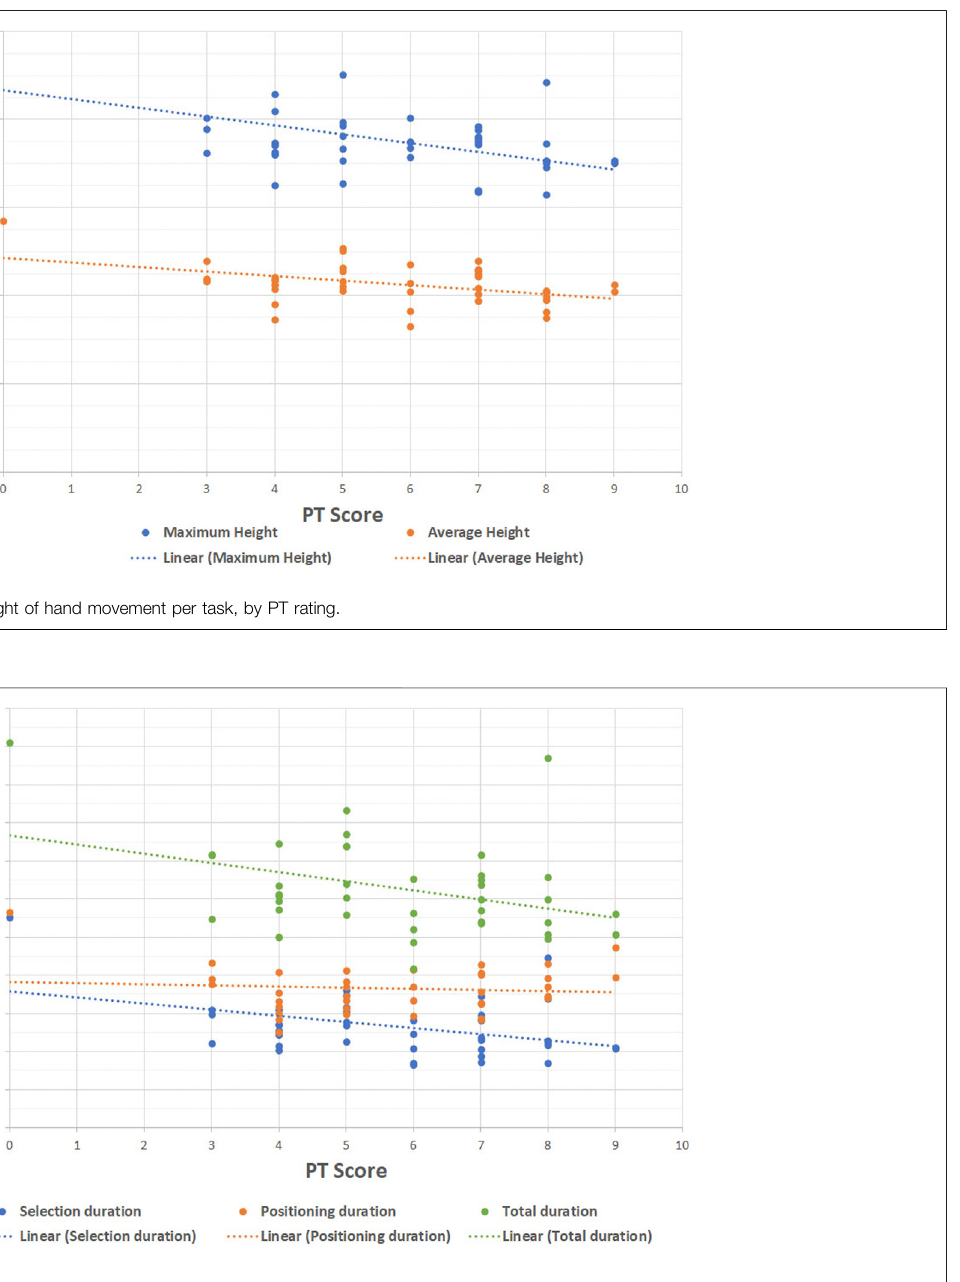
FIGURE 6 | Average task selection, positioning and total time, by PT